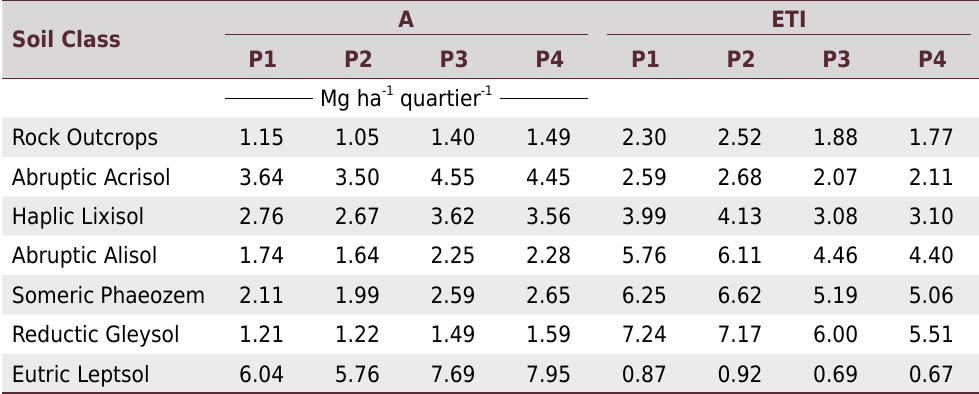
Table 3. Soil loss (A) and erosion tolerance index (ETI) for the soil classes present in the Candiota river watershed